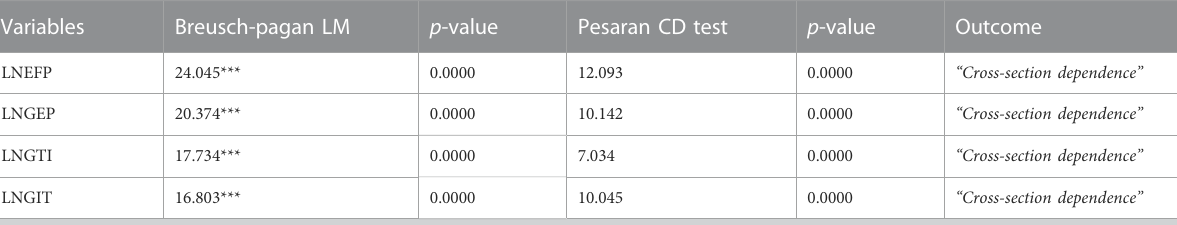
TABLE 3 Analysis of cross sectional dependency test.